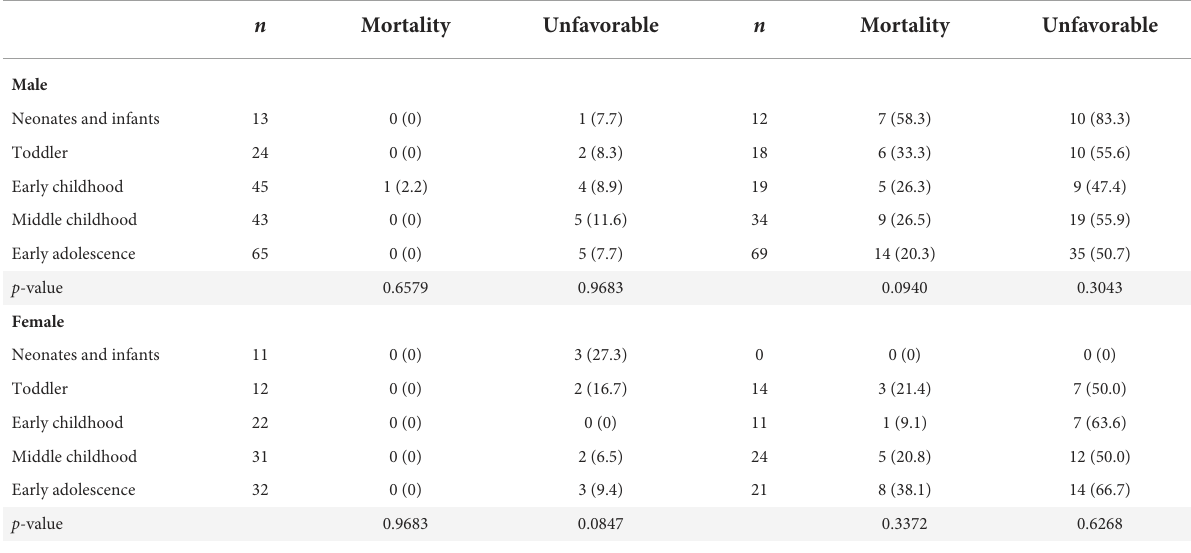
TABLE 4 Outcomes by the severity of injury for TBI cohort (age and sex